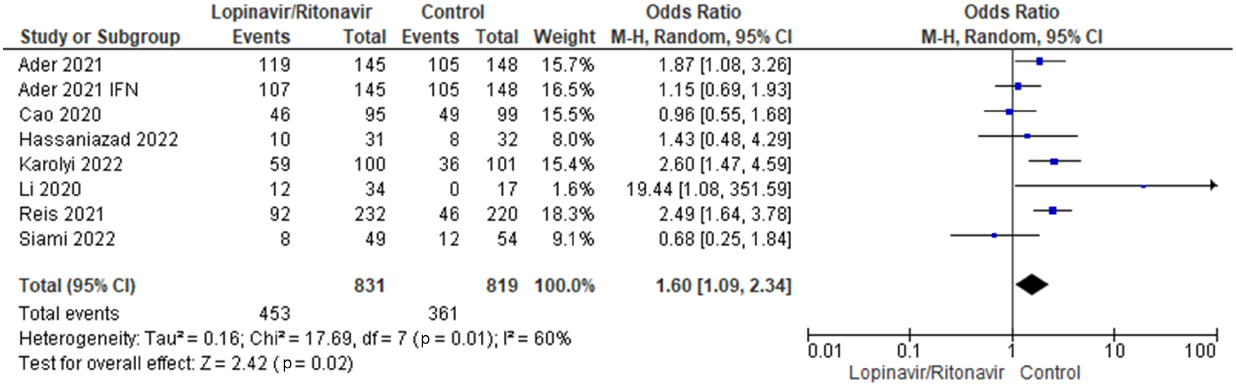
Figure 6. Forest plot analysis of adverse events. The sizes of the blue squares reflect the relative weight of the individual trials. The combined point estimate is shown as a black diamond. The diamond and squares (together with the 95% CIs) located beyond the vertical line (indicating the unit value) show that a result was statistically significant.